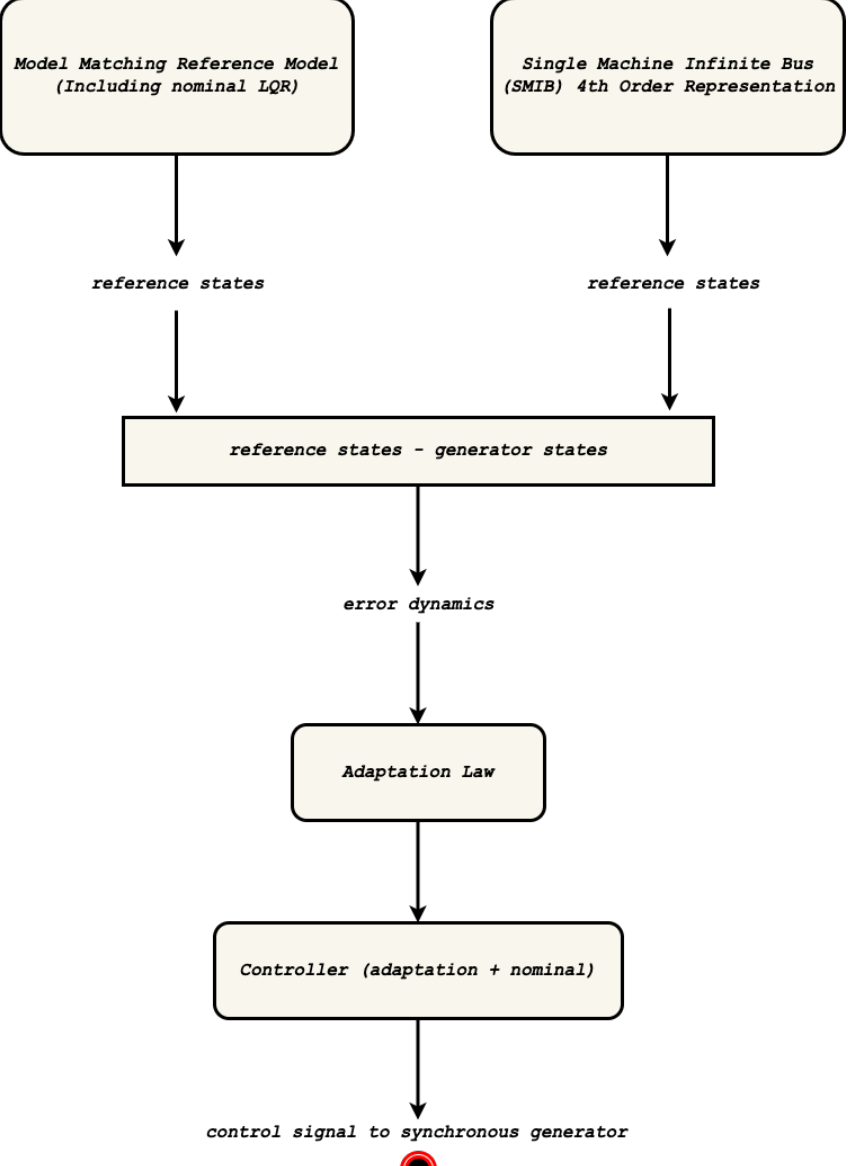
Figure 3. MRAC design architecture for power system inter-area oscillation damping